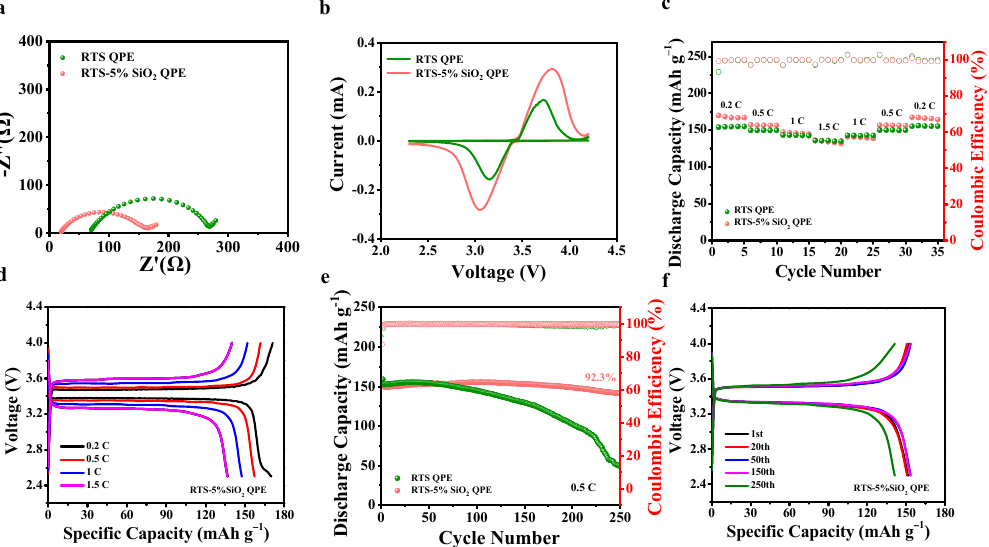
Figure 5. Electrochemical performance of LiFePO 4 /RTS QPE/Li and LiFePO 4 /RTS-5% SiO 2 QPE/Li at room temperature. ( a ) Nyquist curves of the fullcells employing LiFePO 4 and Li. ( b ) CV curves of the fullcells. ( c ) Rate performance of fullcells. Galvanostatic charge/discharge curves of the fullcells cycling at ( d ) different rates from 0.2 C to 1.5 C and ( f ) various cycles at 0.5 C. ( e ) Cycling performance and coulombic efficiency of the fullcells in the voltage range of 2.5 to 4.0 V at 0.5